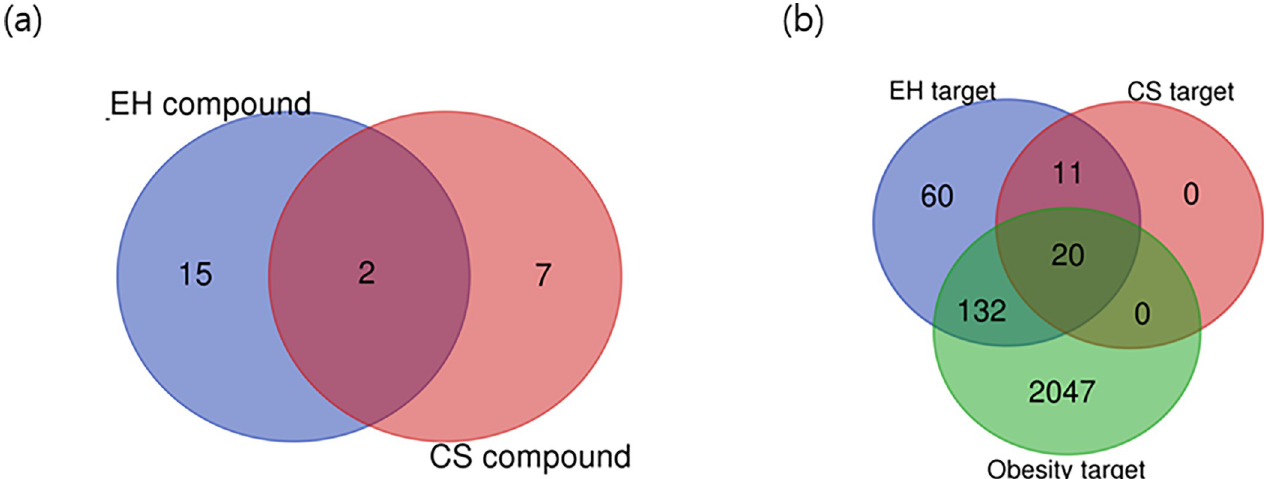
Fig 3. (a) Venn diagram showing the distribution of potent active compounds in EH-CS combinations (b) Venn diagram showing all the targets of EH and CS related to obesity. Data were obtained from TCMSP.